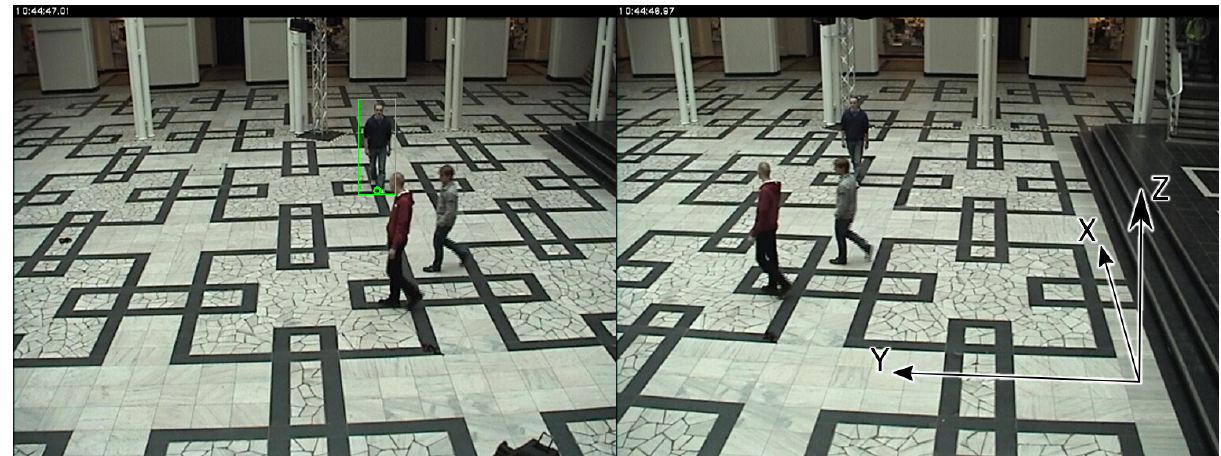
Figure 5: Stereo image pair from test sequence. The coordinate system is translated into the image to show the directions of the axes. In the left image a bounding box is depicted as well as the position derived from our approach (green circle).